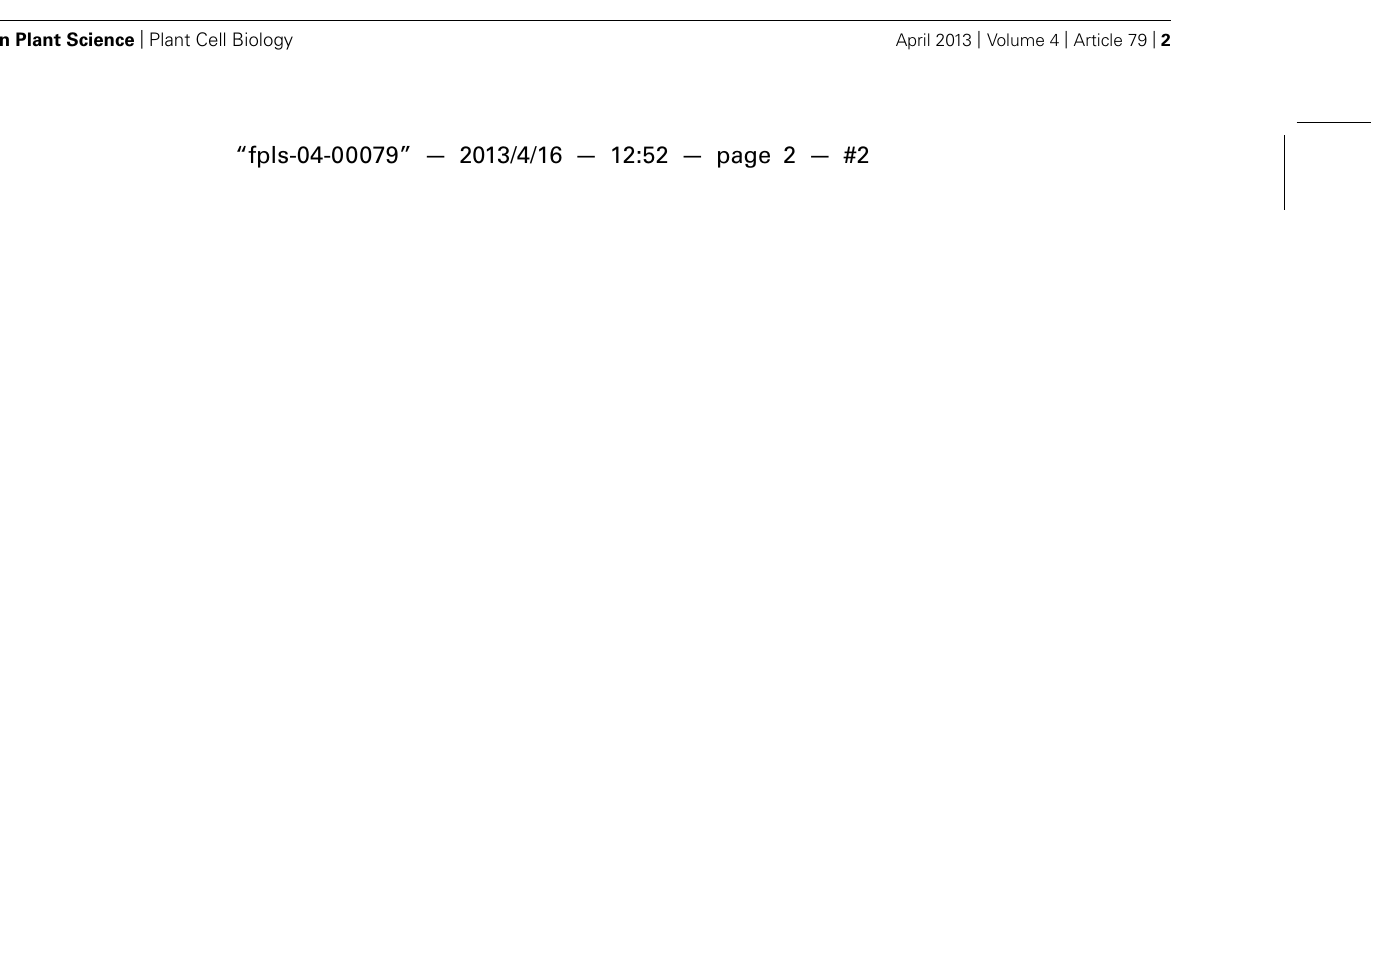
the ripening/senescence program which leads to an increase in ABA and/or ethylene biosynthesis and response in the surrounding tissue. (B) The spectrum of ripening dependencies to ABA and ethylene. All fruit appear to respond to ABA and ethylene. In historically considered “climacteric fruit,” ABA indirectly regulates ripening through ethylene. In “non-climacteric” fruit, the ABA has a more dominant role but the fruit still have ethylene-dependant ripening